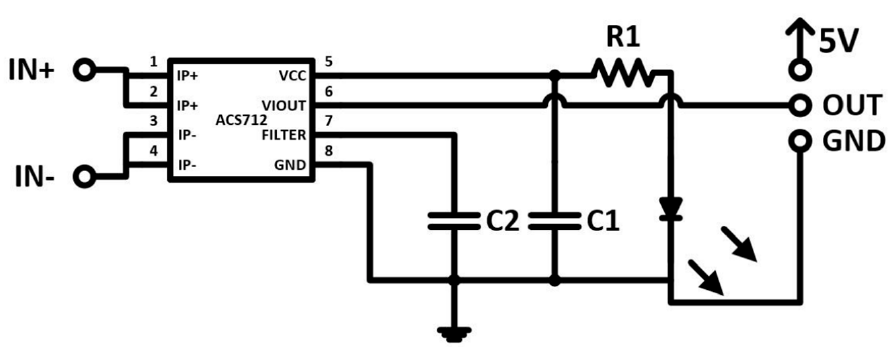
Figure 9. Electrical diagram of the current sensor [45]. Table 4. Constructive variants of the ACS712 sensor [46,47]. Sensor Model